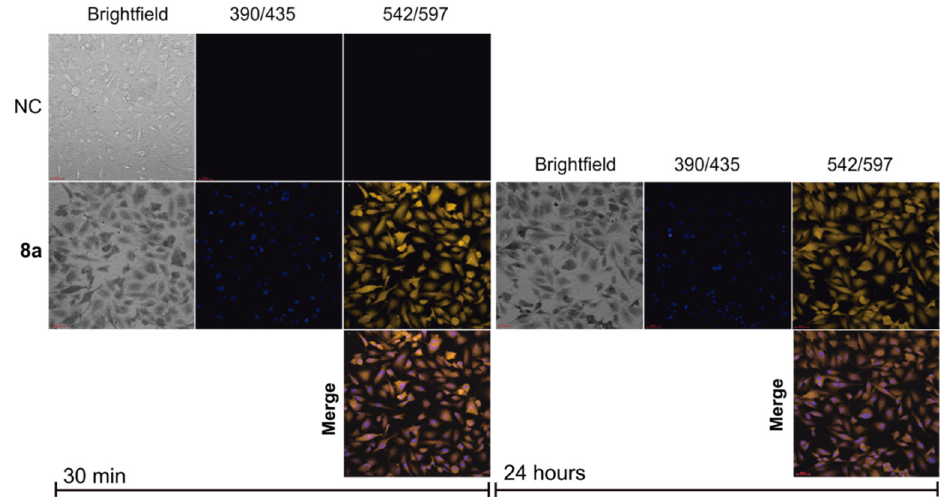
Figure 8. Fluorescent staining of fixed (paraformaldehyde 4%) cells using the meso -substituted cyanine 8a (5 μ M). The first column shows the brightfield, the central column showsthe fluorescence of cells incubated with the nuclear dye Hoescht, and the third column shows cyanine 8a . The result after 30 min of incubation is shown on the left, and that after 24 h of incubation is shown on the right. The first line represents cells without dye (negative control) and the third line represents the merge of Hoescht and cyanine 8a . Scale bar (red) = 60 μ m.